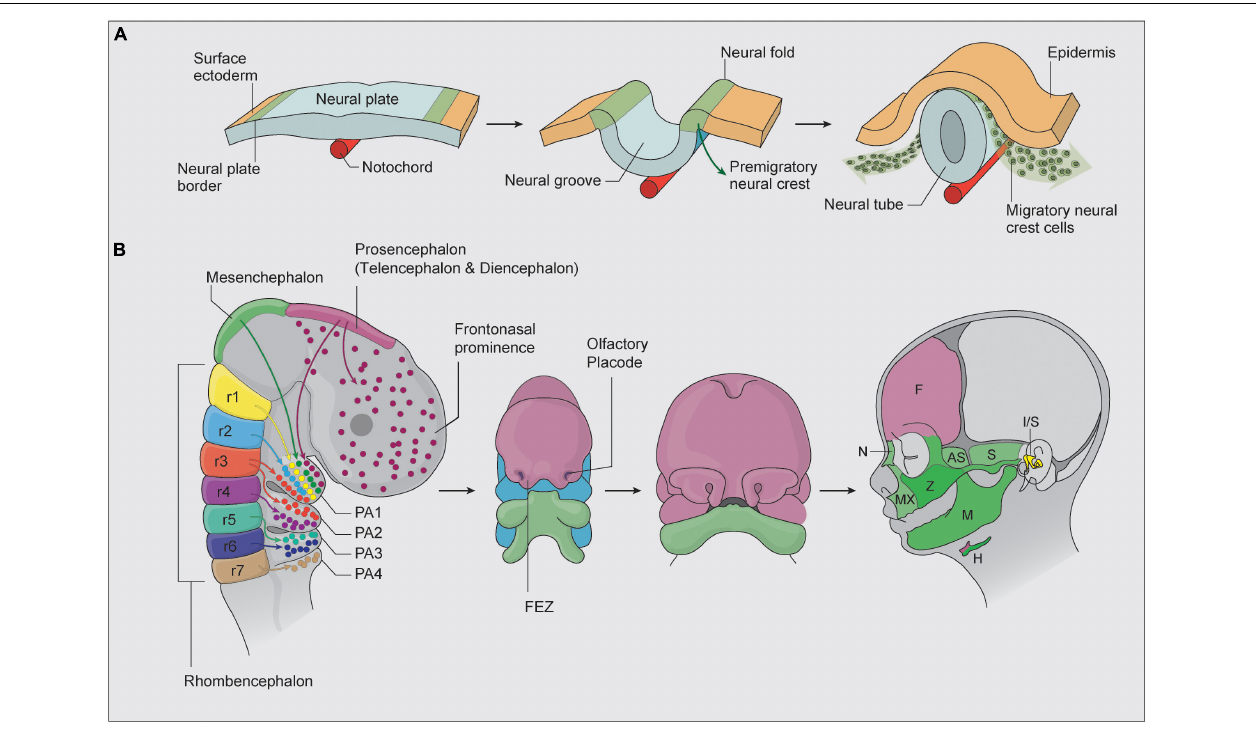
FIGURE 1 | (A) NCC are initially specified within the neural plate border. As the two halves of the neural plate elevate to form a neural tube, NCC are induced and undergo EMT, after which they migrate and colonize the frontonasal prominences, first, second, third, and fourth pharyngeal arches (adapted from Simões-Costa and Bronner, 2015). (B) Cranial NCC patterns of migration and differentiation into the bone and cartilage of the head and face. During embryogenesis, the brain is specified into prosencephalon (diencephalon and telencephalon), mesencephalon, and rhombencephalon regions. The colors highlight regions of the developing face that correspond to NCC populations of different axial origins. The facial prominence and pharyngeal arches then undergo complex morphogenesis to form the structures of the face. AS, alisphenoid bone, F, frontal bone, FEZ, frontonasal ectodermal zone, FNP, frontonasal prominence, H, hyoid bone, I/S, incus and stapes, M, mandible, MX, maxilla, N, nasal bone, PA, pharyngeal arches, r, rhombencephalon, S, squamosal, Z, zygomatic